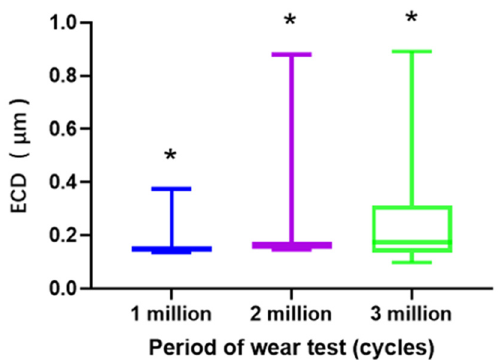
Figure 4. Size of wear particles measured by equivalent circular diameter (ECD), (*: p < 0.05).